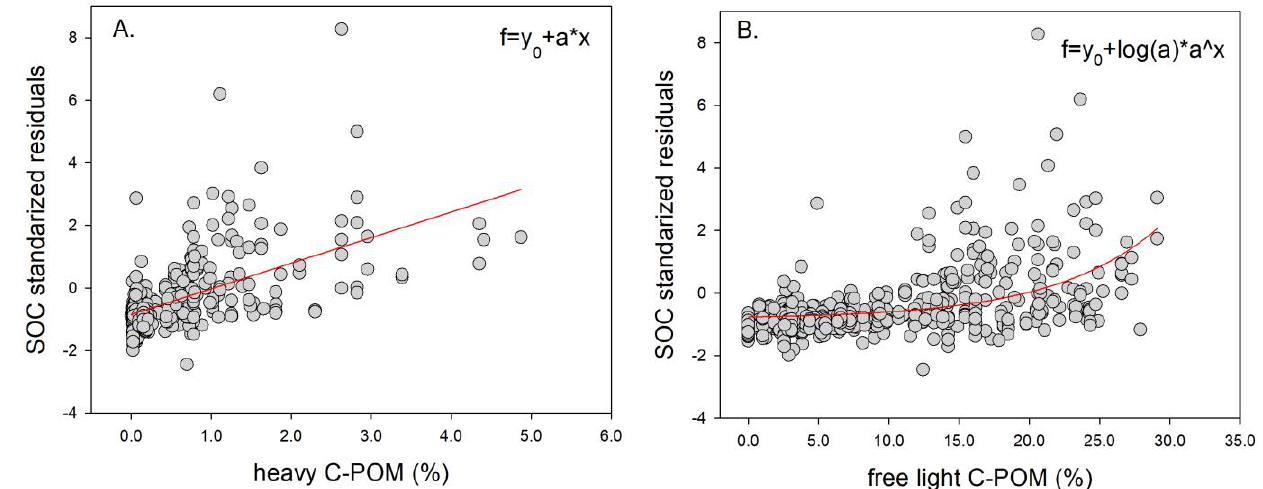
Figure 8. Effect of C concentration stored in particulate organic matter (POM) on under- or over- estimation of SOC by the models. Plots represent standardized residual (residual = measured − predicted) relative to heavy sand-sized OM (heavy POM) ( A ) and free light POM ( B ). Linear and exponential growth (modified simple exponent, 2 parameters) regressions were used to fit patterns for heavy POM and free light POM, respectively.